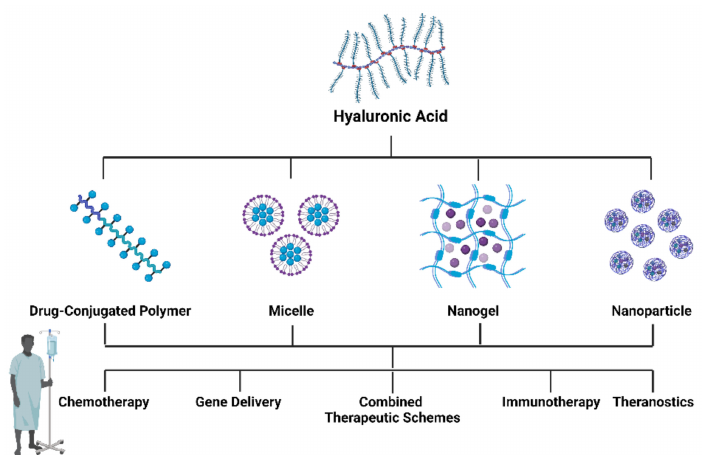
Figure 3. Different formulations of HA-based nanomaterials and their possible applications in cancer therapy. Created with “https://biorender.com/ accessed on 28 September